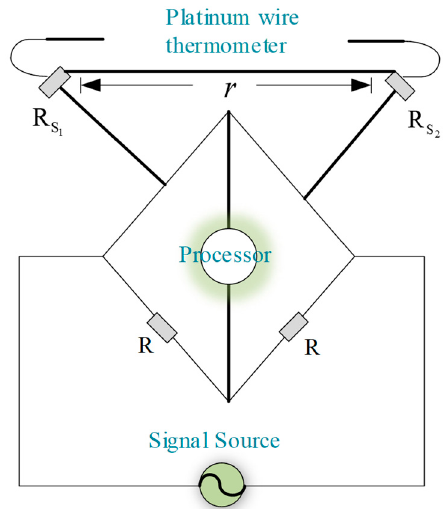
Figure 1. Schematic sketch of the temperature structure measurement